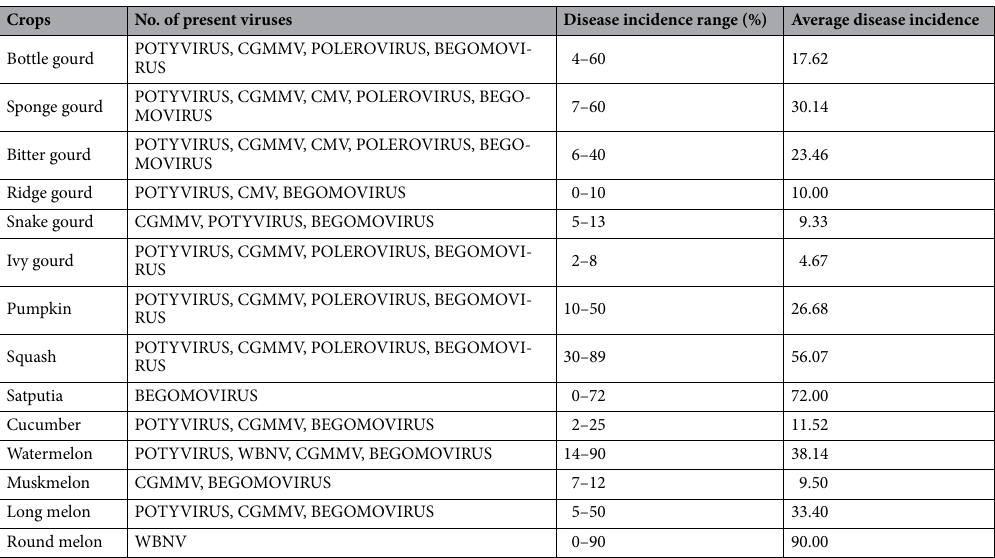
Phylogenetic analysis of viruses.